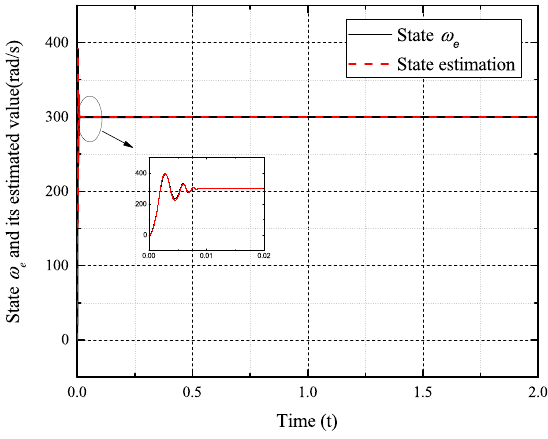
Figure 2. State ω e and its estimated value ˆ ω e .